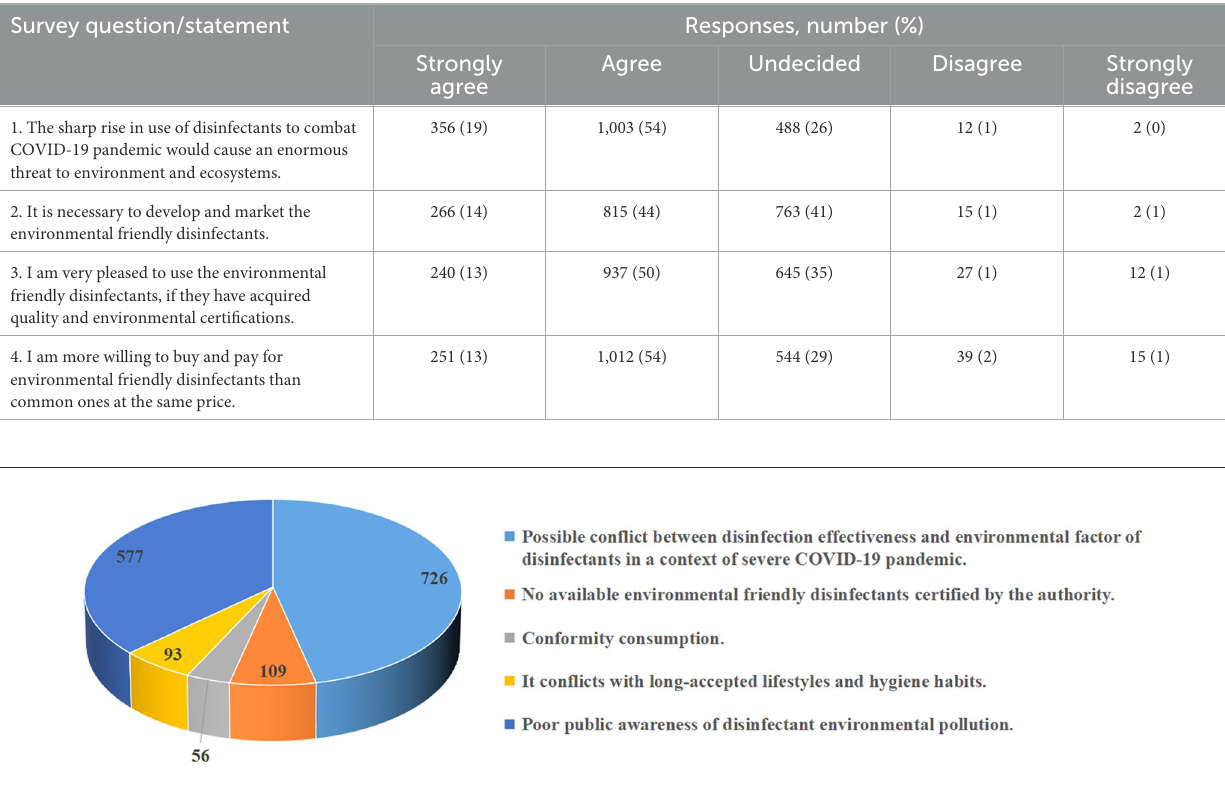
FIGURE2 The most important perceived barrier jeopardizing the usage intention regarding environmental friendly